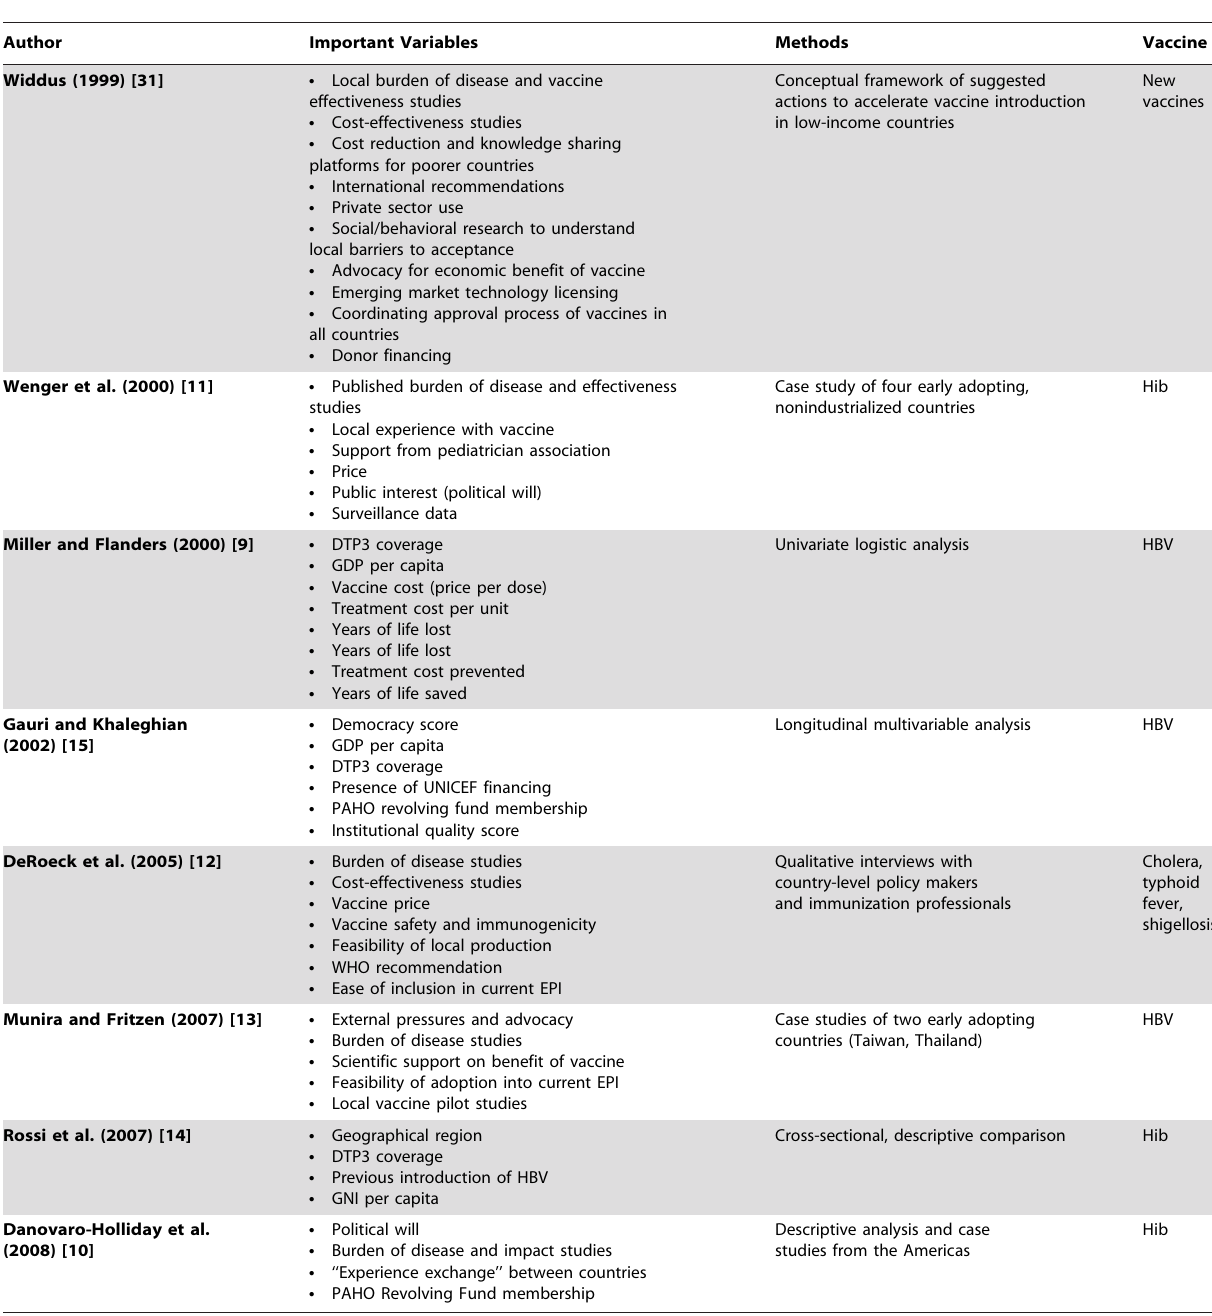
Table 1. Previous findings on factors that influence national vaccine